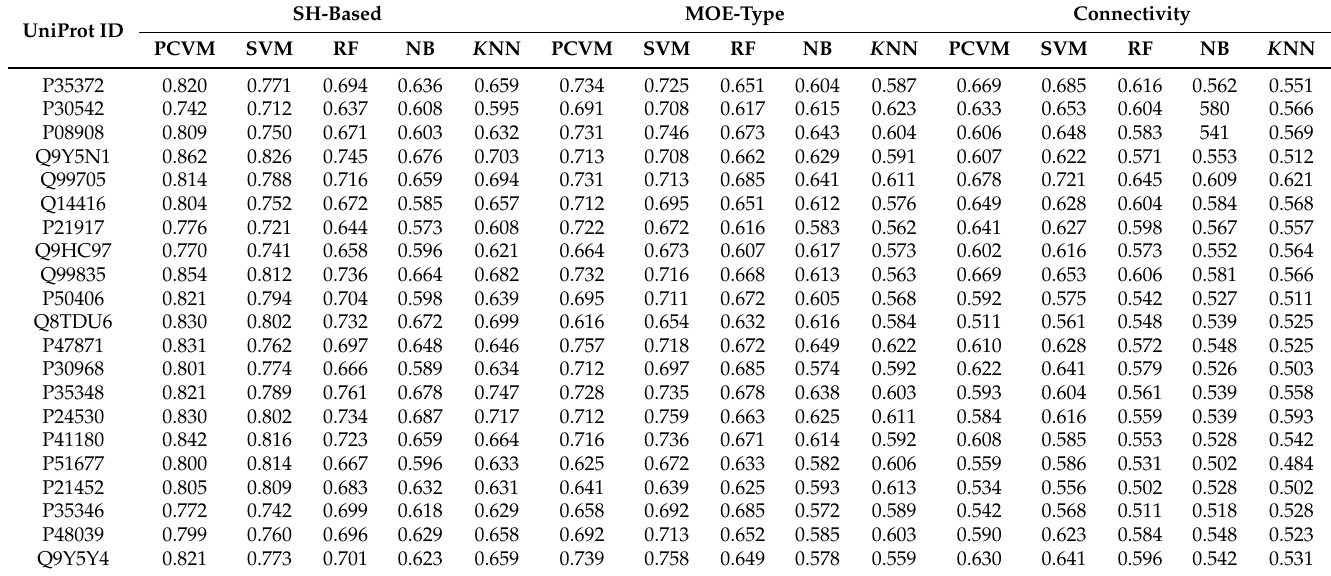
Table 7. Performance comparison of target prediction methods in terms of Accuracy. Scores for the external test